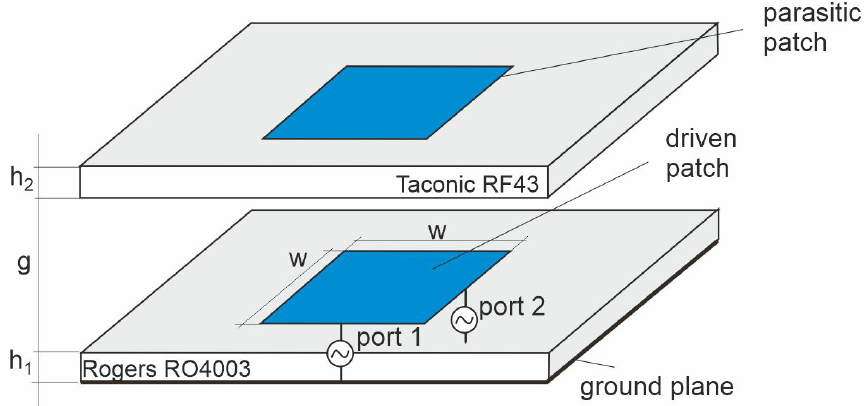
Figure 1. Electromagnetically coupled microstrip antennas.